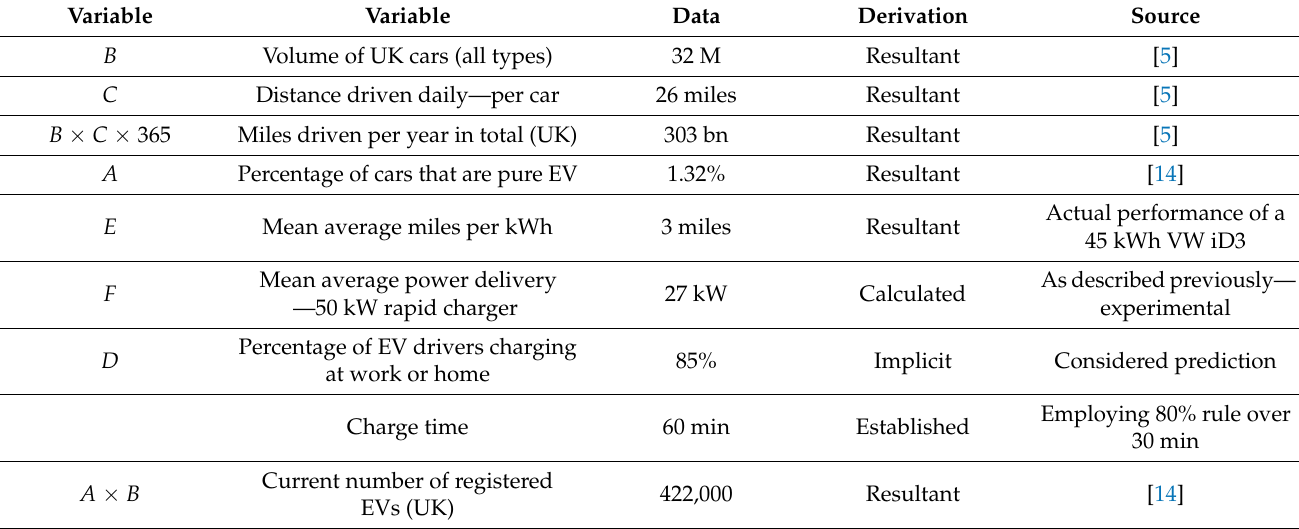
Table 1. Statistical